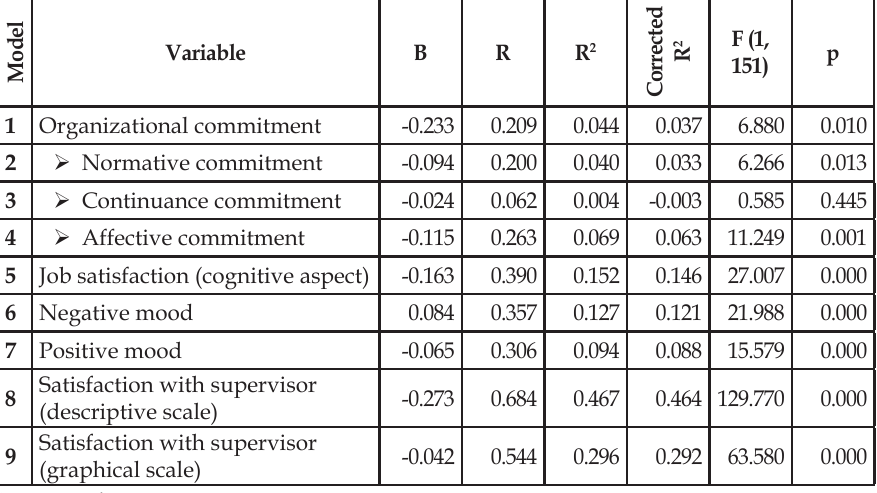
Table 4. The simple linear regression models: the effect of perceived supervisor`s subclinical psychopathy on subordinate`s organizational commitment, job satis- faction and satisfaction with